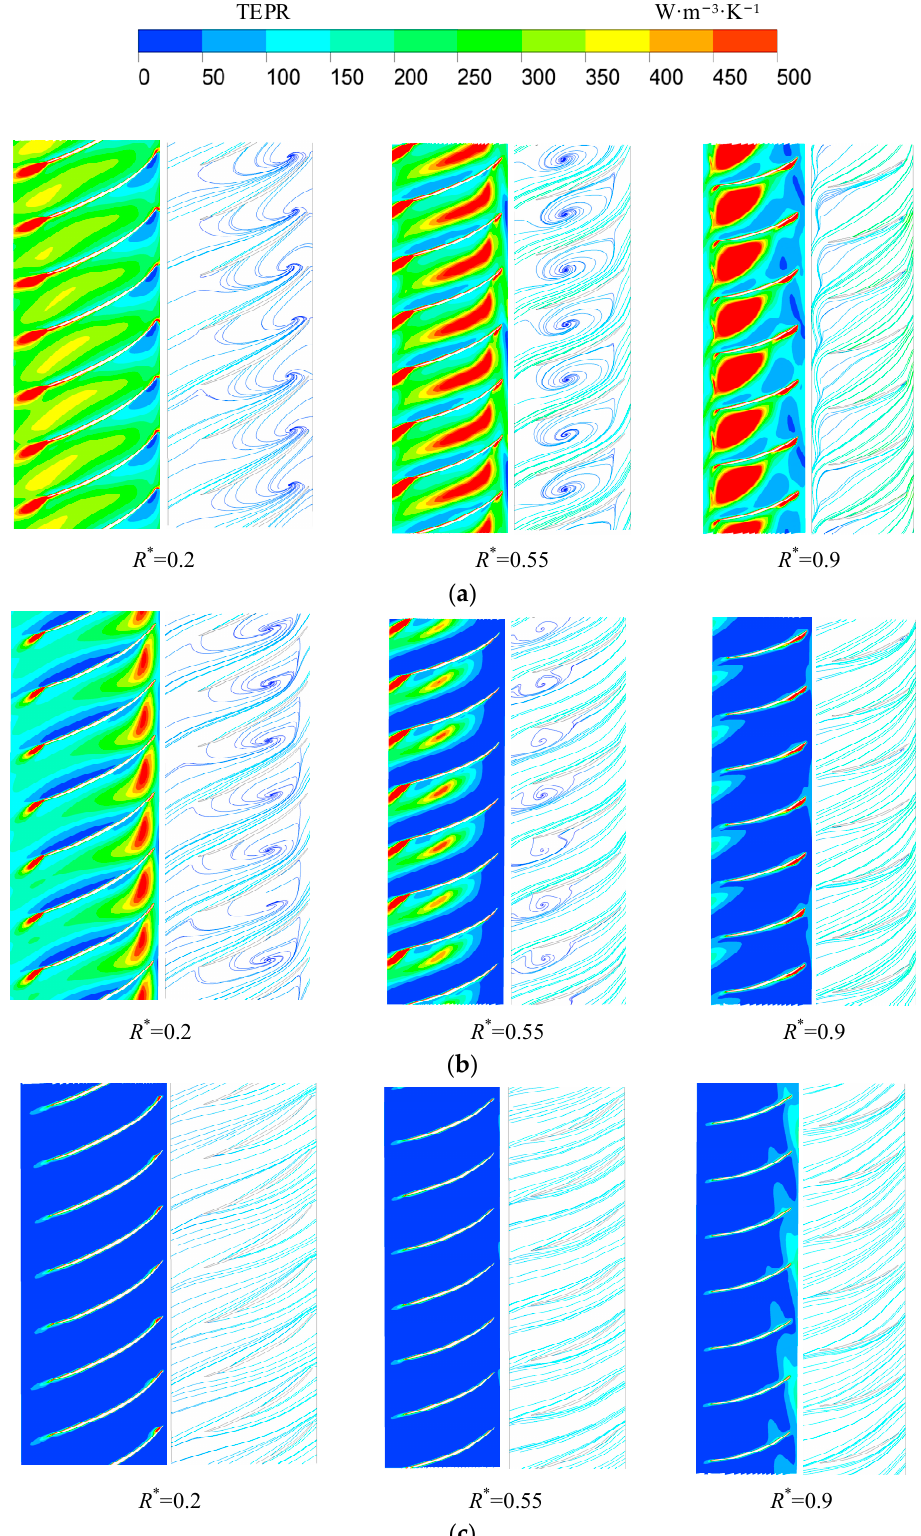
Figure 14. The distribution of TEPR and velocity in the guide vanes at ( a ) 800 m 3 /h ( b ) 1200 m 3 /h and ( c ) 1600 m 3 /h.